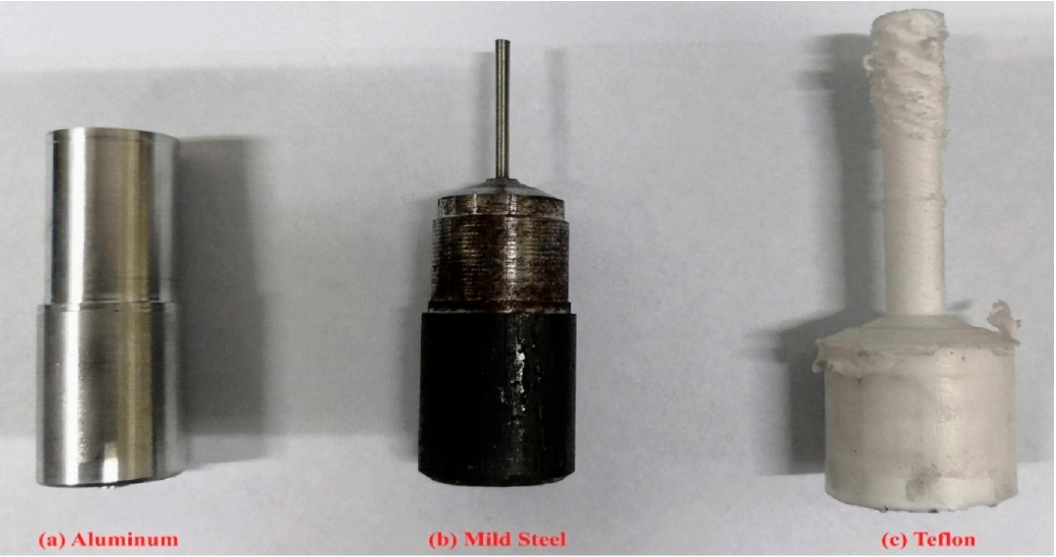
Figure 8. Workpieces of all three types on which turning operations have been performed.